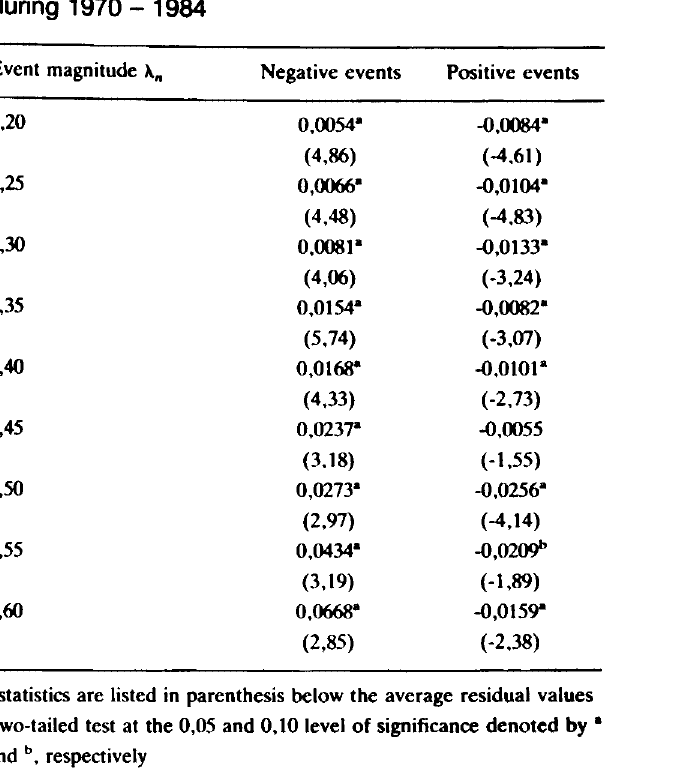
Table 2 Event intensity: average residuals for the